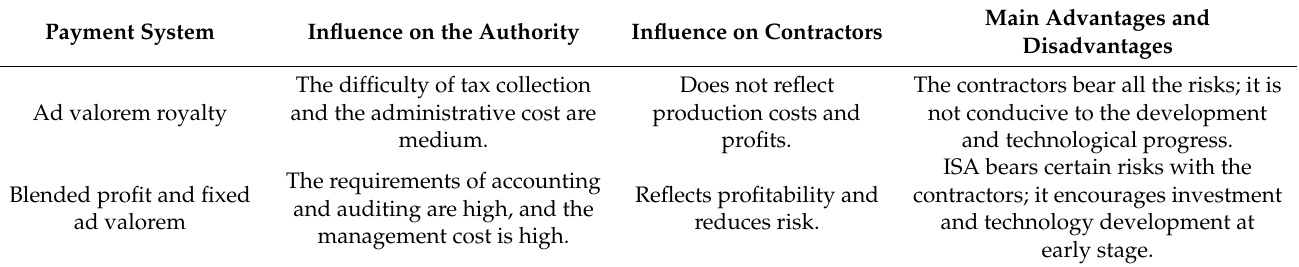
Table 13. The influence, advantages, and disadvantages of different payment